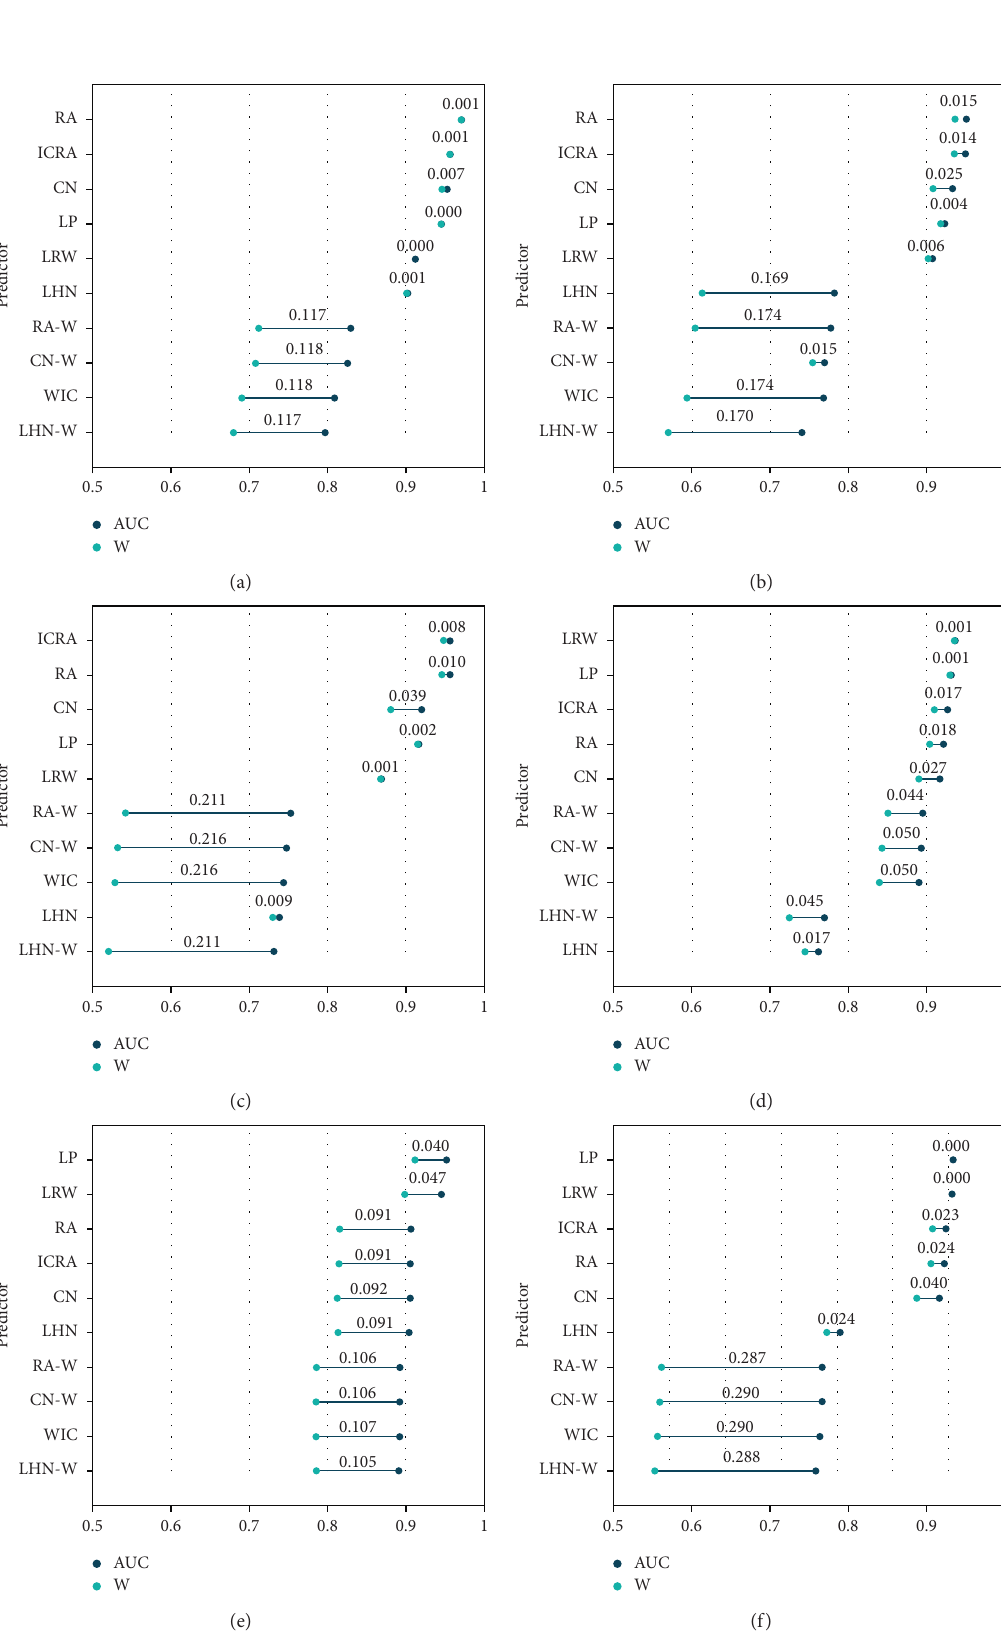
Figure 2: Difference in accuracy for each predictor under AUC and W-index metrics. (a) Jazz accuracy change W-AUC. (b) USAir accuracy change W-AUC. (c) Metabolic accuracy change W-AUC. (d) PB accuracy change W-AUC. (e) Tvshow accuracy change W-AUC. (f) Yeast accuracy change